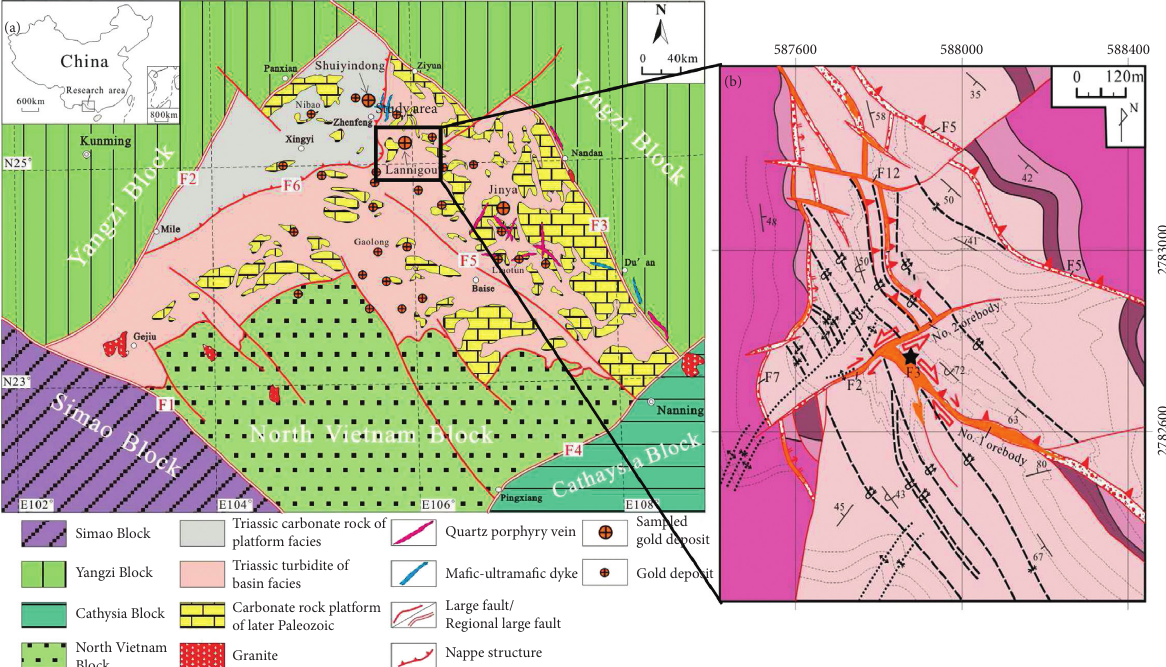
Figure 1: (a) Regional geological map of the Yunnan-Guizhou-Guangxi “Golden Triangle” region. (b) Schematic geological map of the Jinfeng gold deposit in Guizhou with the sampling locations.